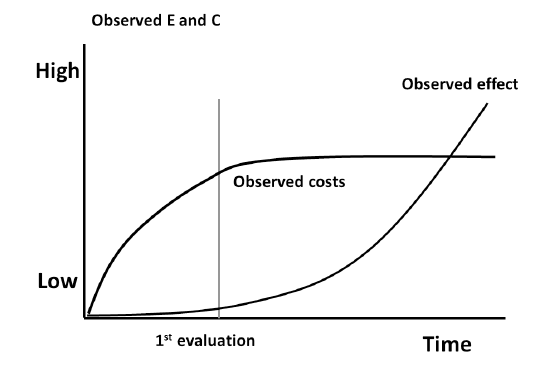
Fig. 5. Development of costs and effect of policy on Good Environmental